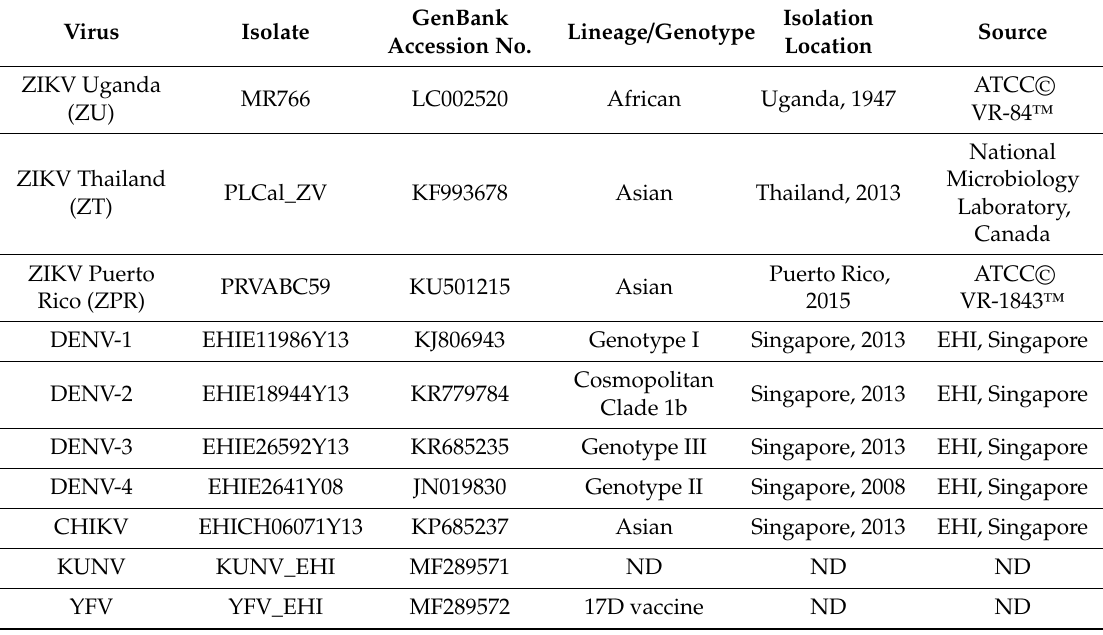
Table 1. Details of virus isolates used in the